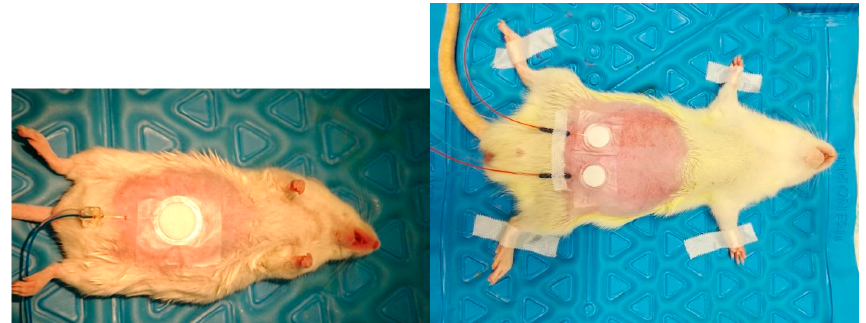
Figure 1. Implantation of microdialysis probes and placement of drug-containing patches in a representative mouse (left) and rat (right) in transdermal microdialysis experiments.